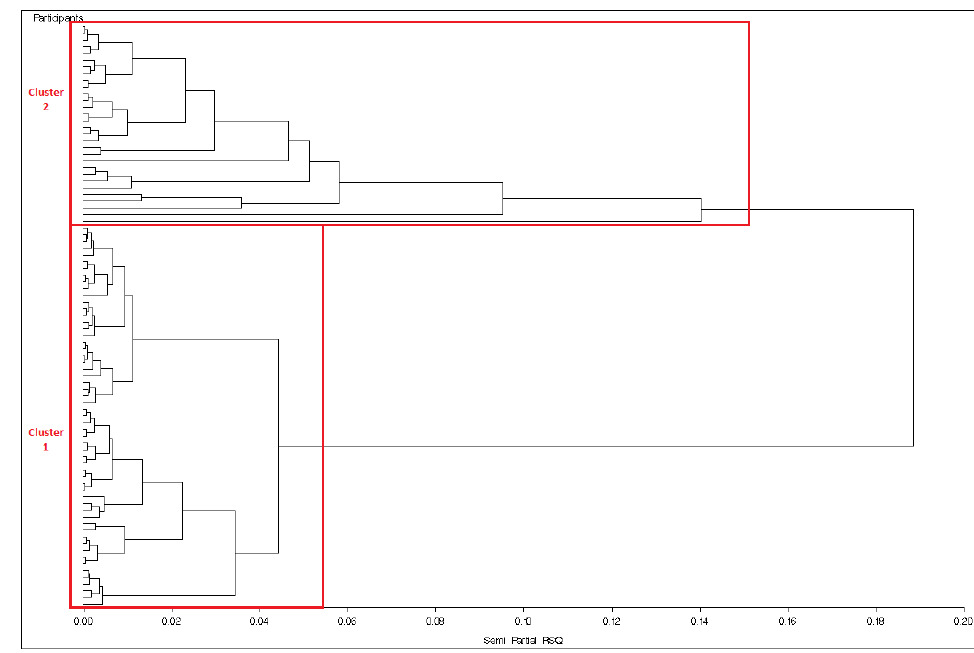
Figure 2 . Clusters according to baseline peptides. Figure 2. Clusters according to baseline